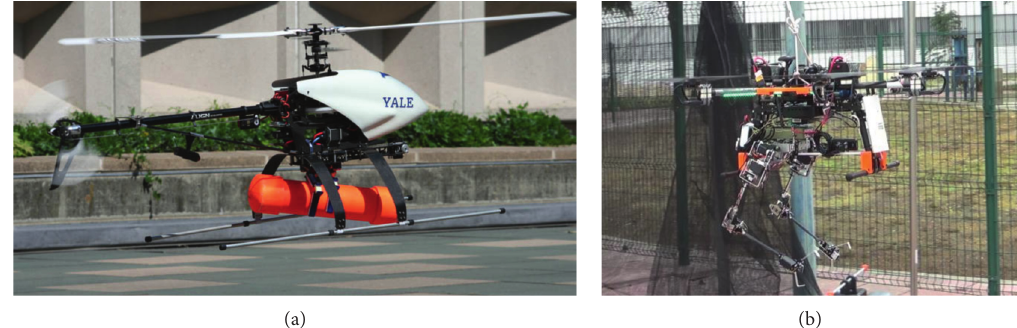
Figure 1: Examples of aerial robots. (a) Yale University. (b) University of Seville.